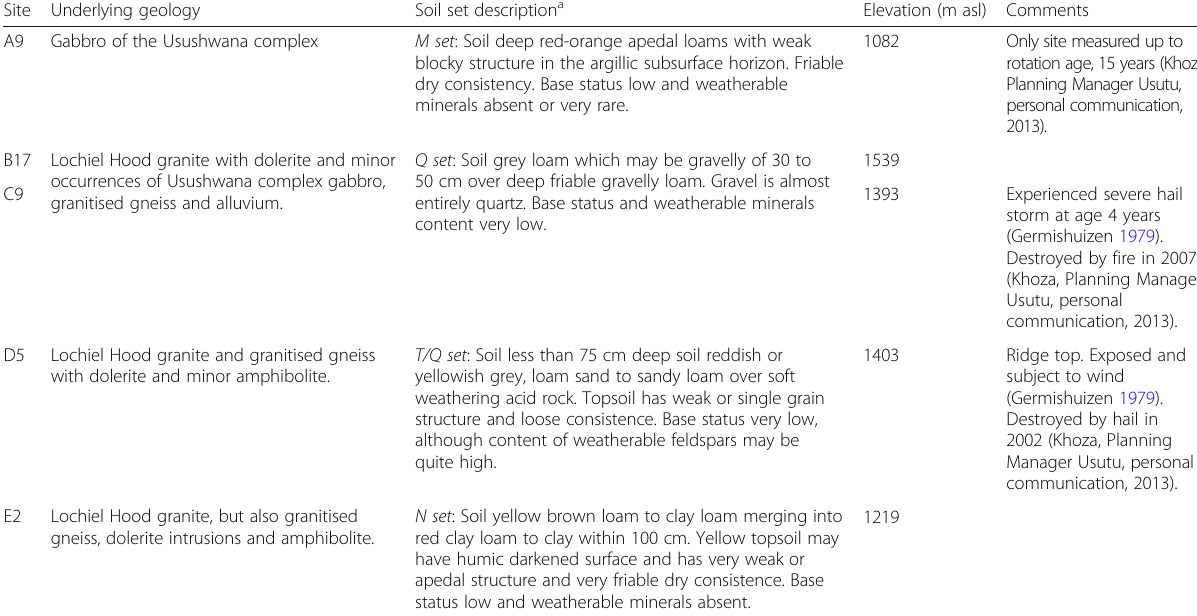
Table 1 Description of the underlying geology, soil set and additional comments related to the five sites used for the first trial Site Underlying geology